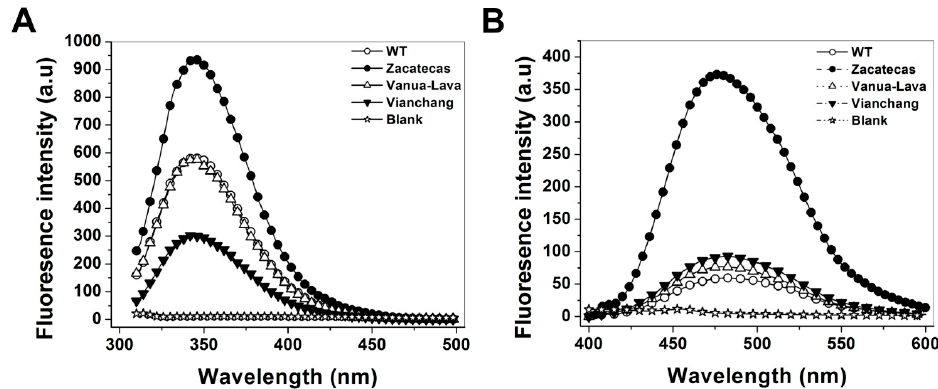
Figure 8. Conformational changes in the tertiary structure of recombinant human WT G6PD enzymes